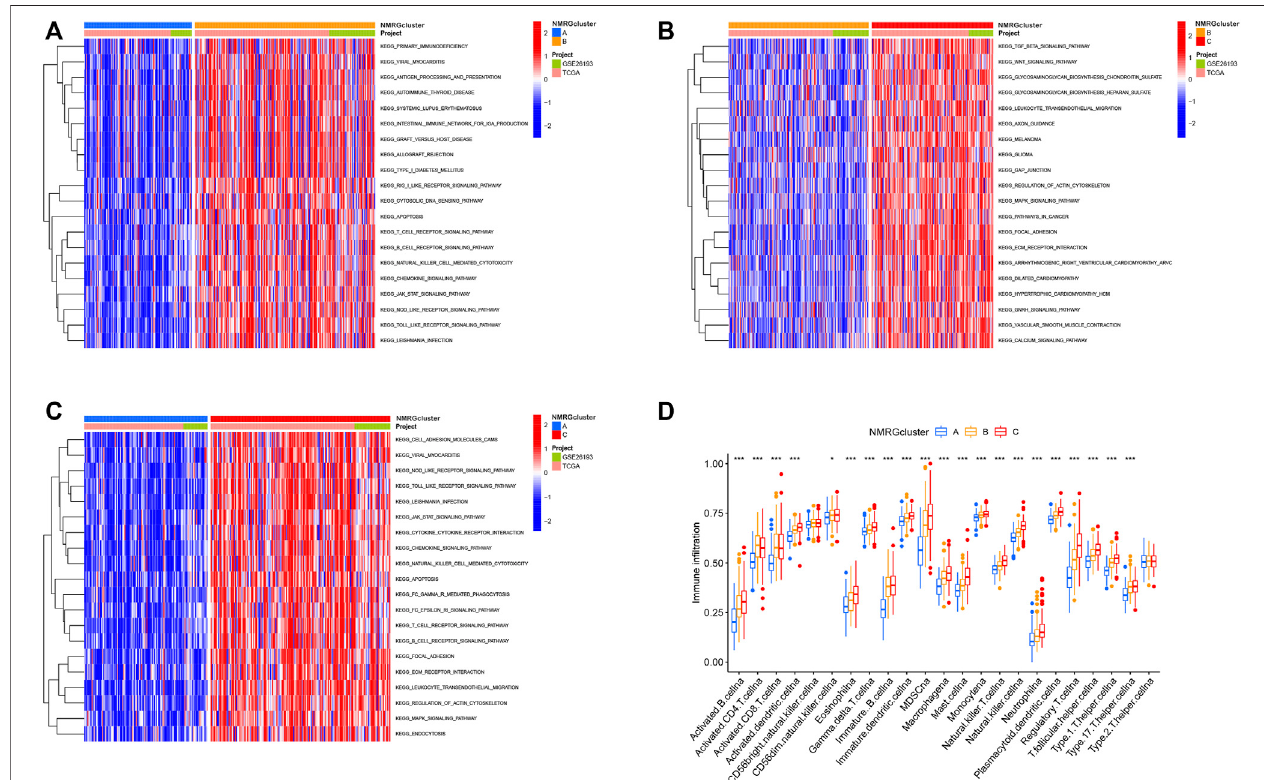
FIGURE 5 | Identi fi cation of functional pathway enrichment and immune cell in fi ltration between different subtypes. (A – C) GSVA enrichment analysis shows the activation states of biological pathways in different subtypes. The heat map was used to visualize these biological processes, and red represented activated pathways and blue represented inhibited pathways. (D) Tumor microenvironment analysis of NMRGcluster subtypes. * p < 0.05, ** p < 0.01, *** p < 0.001.